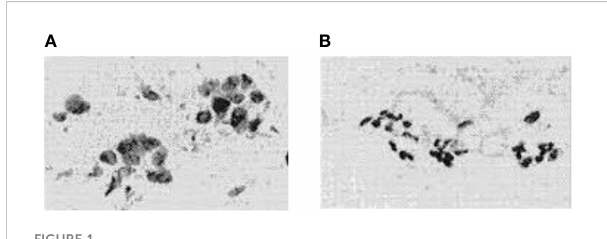
FIGURE 1 FNA ’ s digitized photos were: (A) is malignant and (B) is benign